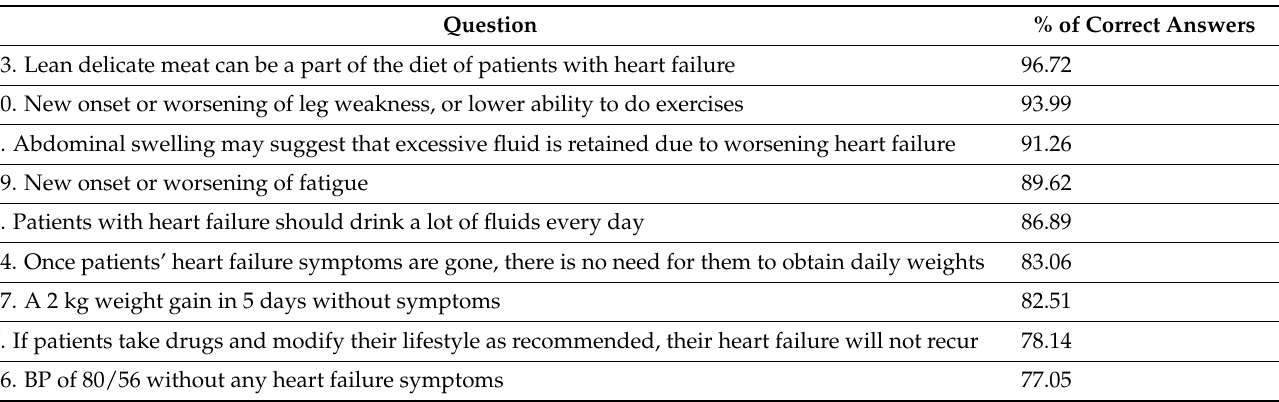
Table 2. Percentage of correct answers to all questions from the Nurses’ Knowledge of Heart Failure Education Principles survey (best